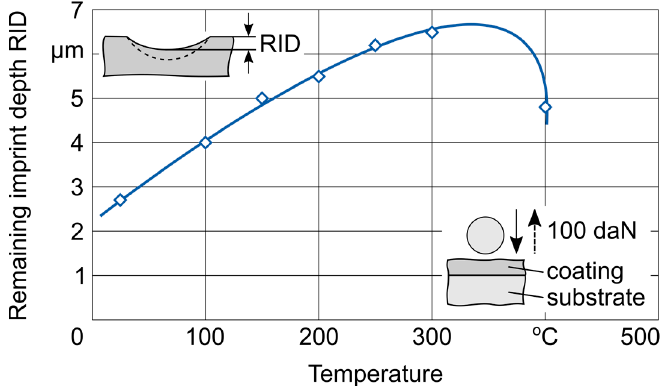
Figure 5. Developed craters on the high-speed steel surfaces after 1000 impacts at constant load and various temperatures.